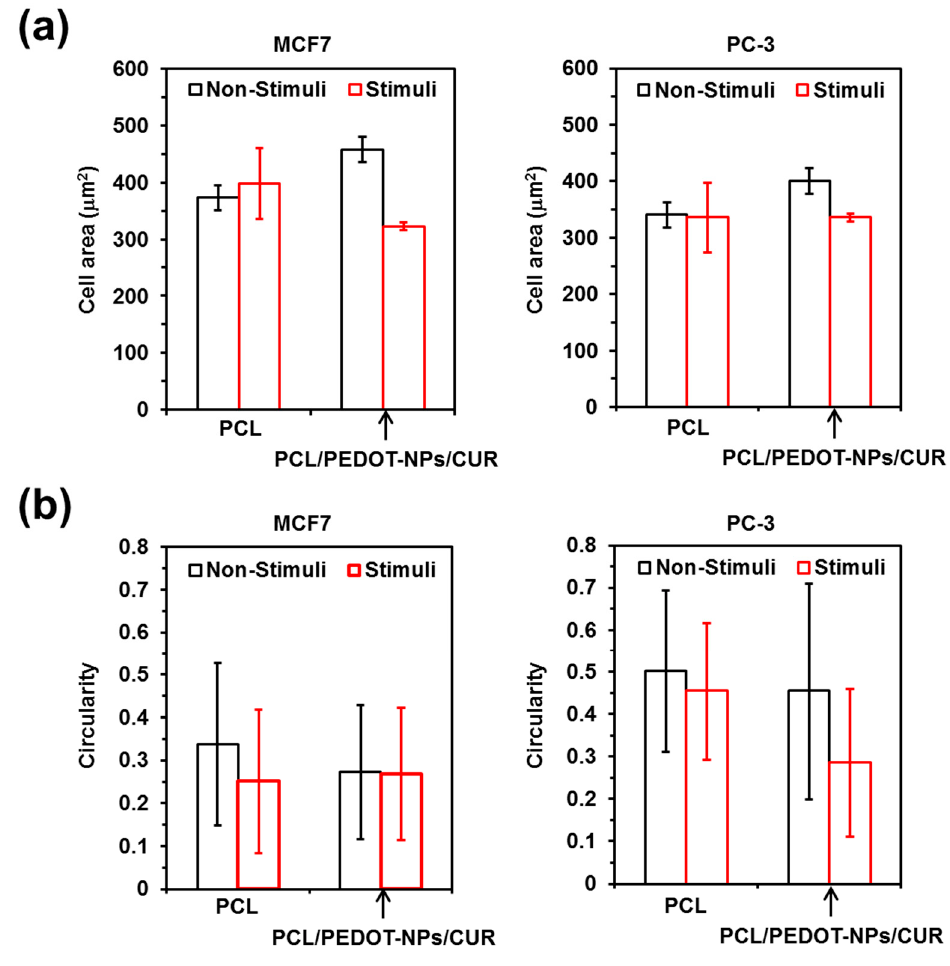
Figure 6. Quantification of ( a ) cell area and ( b ) cell circularity of MCF7 and PC-3 cells cultured onto both PCL and PCL / PEDOT-NPs / CUR fibrous mats without and with electrical stimuli (1 pulse of 0.5 V for 1 min). Each data point corresponds to the average of three samples and the error bars refer to the respective standard deviation.